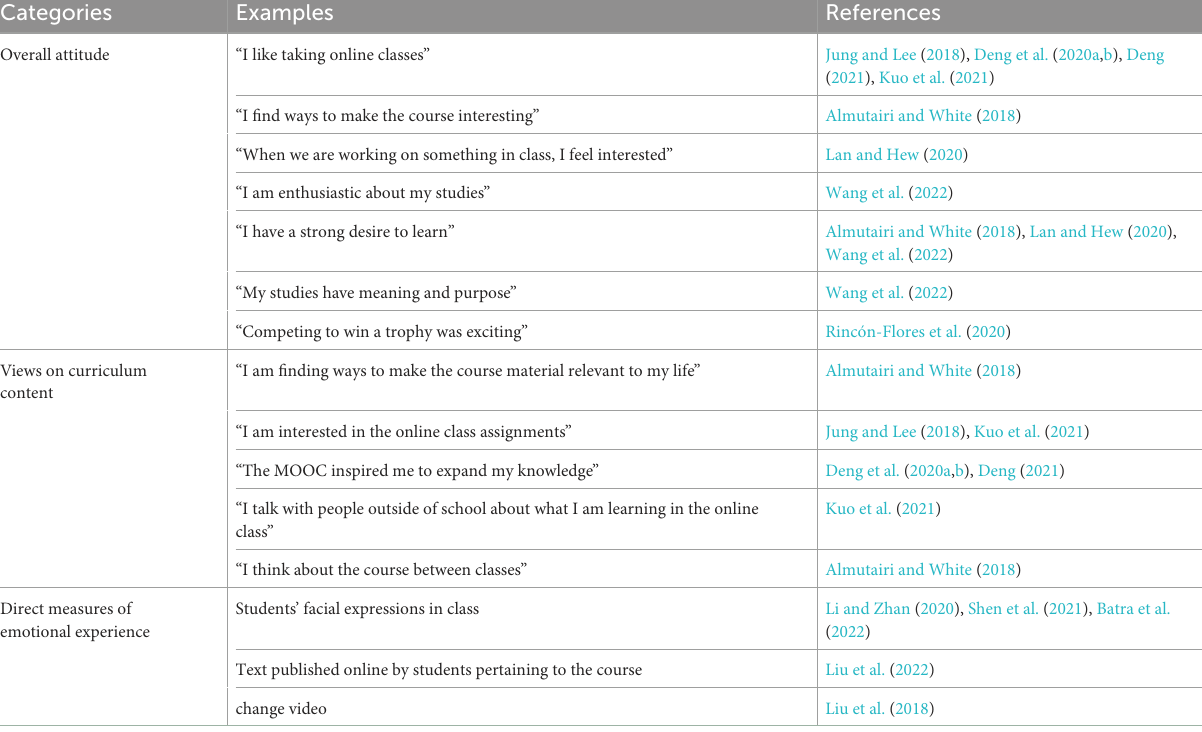
TABLE 4 Categories of emotional